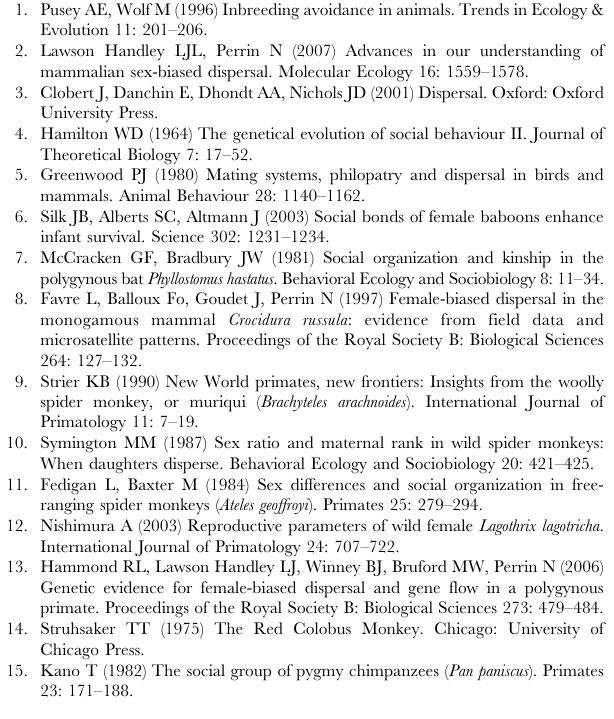
respective group sizes. Data were derived from human hunter-